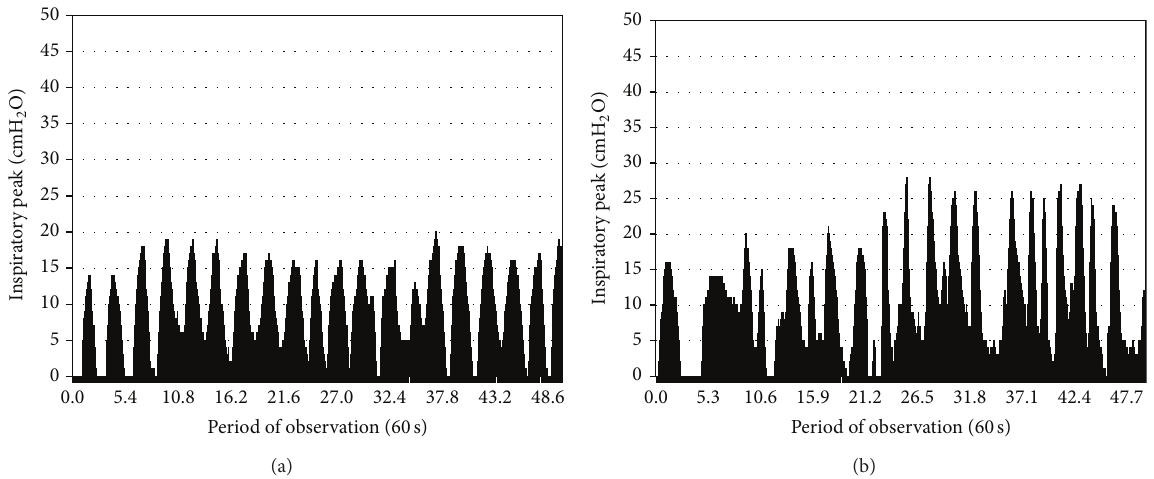
Figure 1: Graphics of inspiratory peaks by TIE index method. (a) At start of program on mechanical ventilation dependence; (b) 14 days after treatment associated with successful weaning.